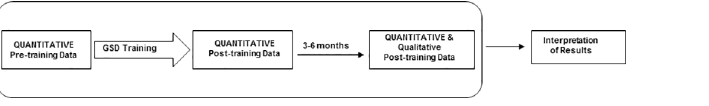
Fig 1. Study design for gender and sexual diversity